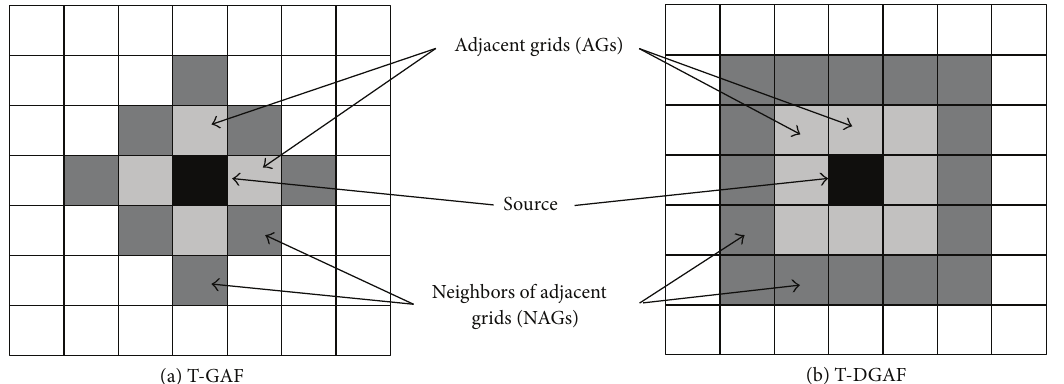
Figure 3: Example of two-level neighbor sharing